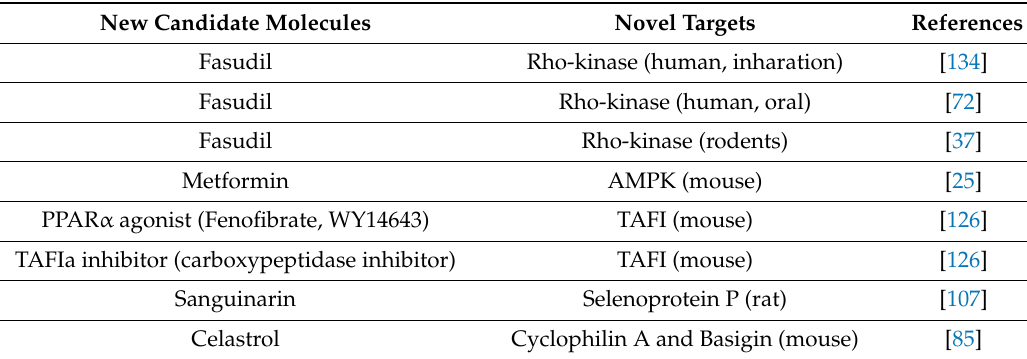
Table 1. New candidate molecules for novel targets in pulmonary